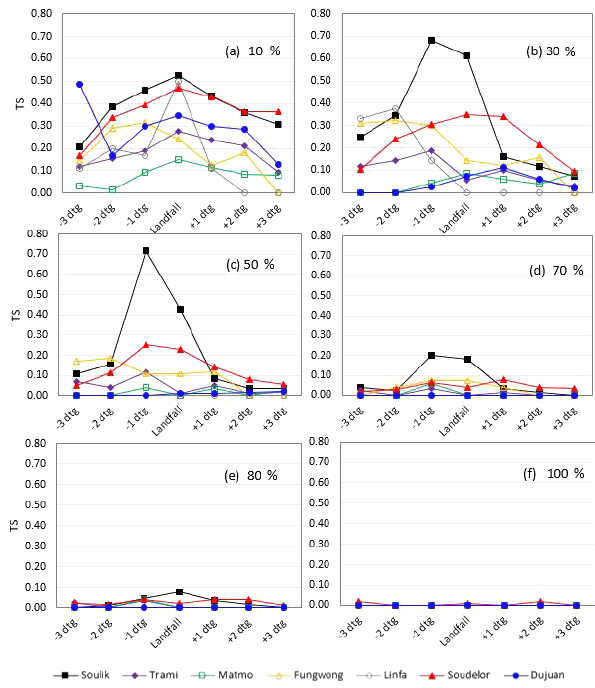
Figure 7. Comparisons of TS performance with a 1 to 24h lead time considering various probability thresholds without a data as- similation technique.